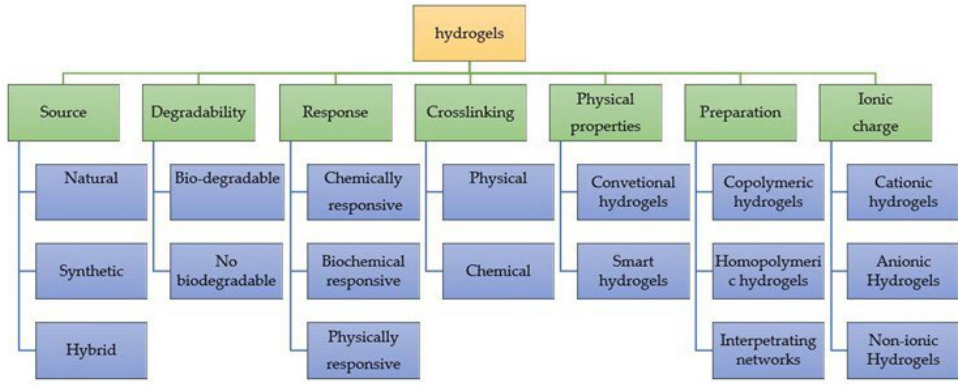
Figure 3. Representative scheme of the classification of hydrogels.